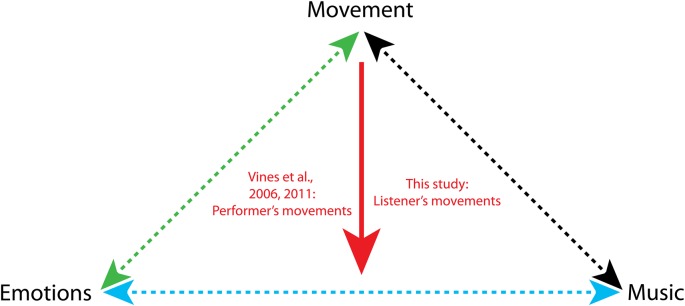
Relationship between movements, music and emotions. The green arrow indicates the bidirectional relationship between emotions and movements (Darwin, 1872; Ekman et al., 1969; Izard, 1971; Meijer, 1989; Stepper and Strack, 1993; Dittrich et al., 1996; Wallbott, 1998; Montepare et al., 1999; Pollick et al., 2001; Sawada et al., 2003; Atkinson et al., 2004, 2007; Niedenthal, 2007; Roether et al., 2009; Carney et al., 2010; Havas et al., 2010; Dael et al., 2012; Havas and Matheson, 2013; Arminjon et al., 2015; de Gelder et al., 2015). The cyan arrow indicates the bidirectional relationship between emotions and music (Shatin, 1970; Fisher and Greenberg, 1972; McFarland, 1985; Nyklíček et al., 1997; Peretz et al., 1998; Blood and Zatorre, 2001; Gomez and Danuser, 2004; Bigand et al., 2005; Baumgartner et al., 2006; Zentner et al., 2008; Coutinho and Cangelosi, 2011; Saarikallio, 2011; Thoma et al., 2012; Koelsch, 2014; Juslin et al., 2015; Vuilleumier and Trost, 2015). The black arrow indicates the bidirectional relationship between movement and music (Clynes, 1977; Flohr and Brown, 1979; Needler and Baer, 1982; Sims, 1985; Davidson, 1993; Worden, 1998; Boone and Cunningham, 2001; Leman, 2007, 2010; Toiviainen et al., 2010; Janata et al., 2012; Burger et al., 2013, 2014; Maes and Leman, 2013; Van Dyck et al., 2013; Witek et al., 2014, 2017; Maes, 2016).